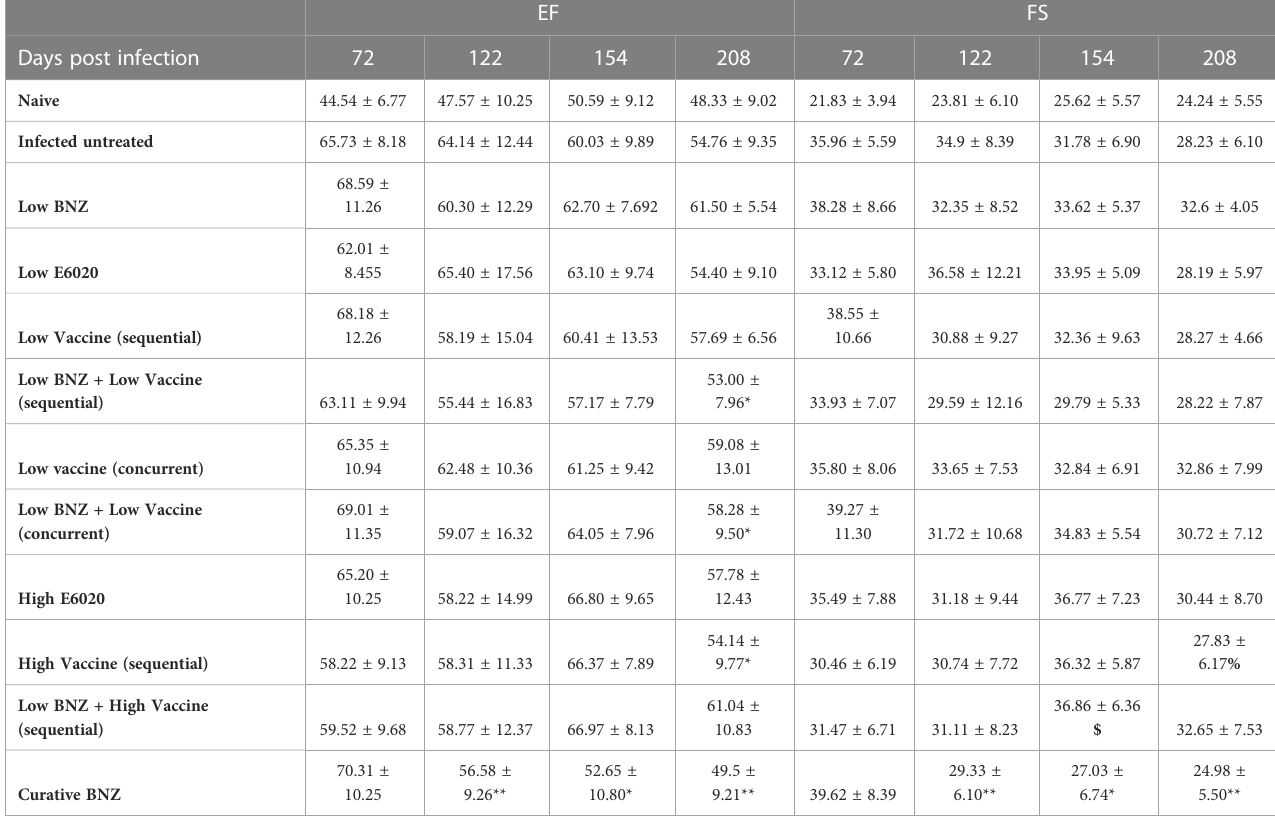
TABLE 4 Left ventricular ejection fraction and fractional